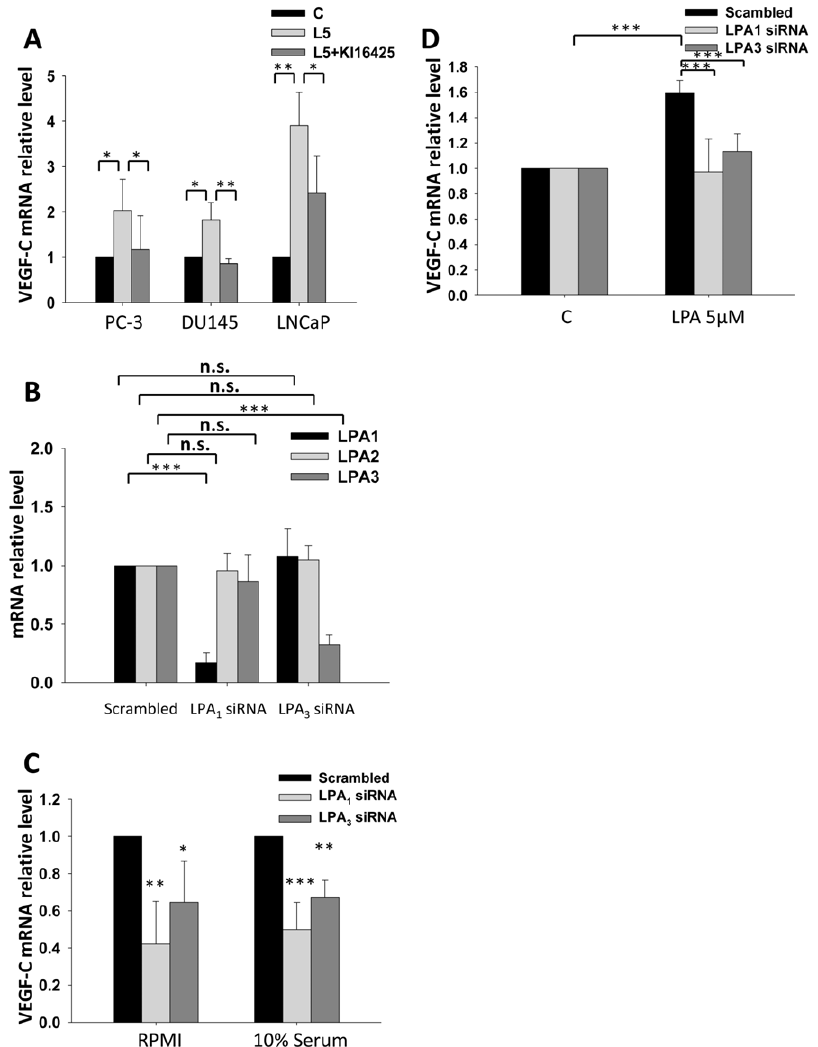
Figure 2. The role of LPA 1 and LPA 3 in LPA-enhanced vascular endothelial growth factor (VEGF)-C expression. (A) LNCaP, DU-145 and PC-3 cells were treated with 10 m M Ki16425, an antagonist of LPA 1 and LPA 3 , followed by 5 m M LPA for 2 h (L5: 5 m M LPA). Relative VEGF-C mRNA levels were measured. (B) PC-3 cells were transiently transfected with LPA 1 and LPA 3 siRNA. (C) The basal VEGF-C mRNA expression of PC-3 cells transfected with LPA 1 or LPA 3 siRNA was measured in a 10% FBS and no serum conditioned cell culture. (D) PC-3 cells transfected with LPA 1 and LPA 3 siRNA were treated with LPA, and VEGF-C mRNA was measured. mRNA was reverse-transcribed and analyzed by a real-time PCR. The relative levels of VEGF-C normalized to GAPDH and b -actin are shown. * Statistically different compared to the vehicle-incubated sample treated with LPA (* p , 0.05; ** p , 0.01; *** p , 0.001).